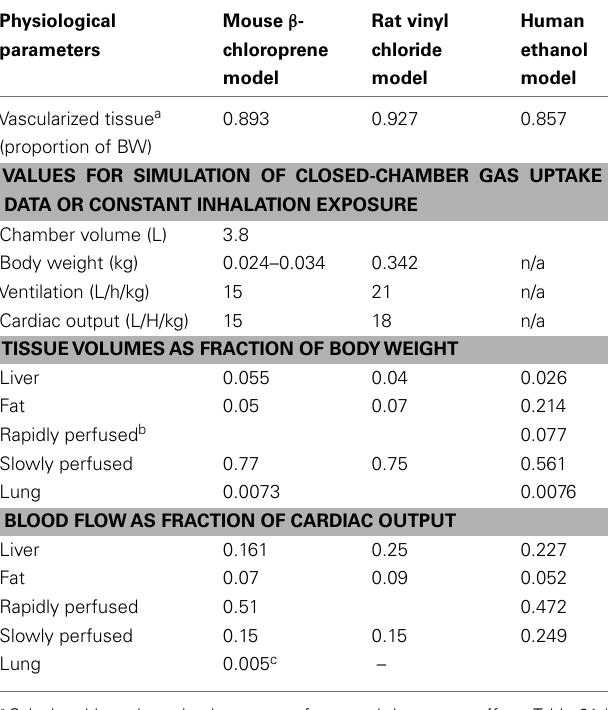
Table 2 |Anatomical and physiological parameters used for the three PBPK models.